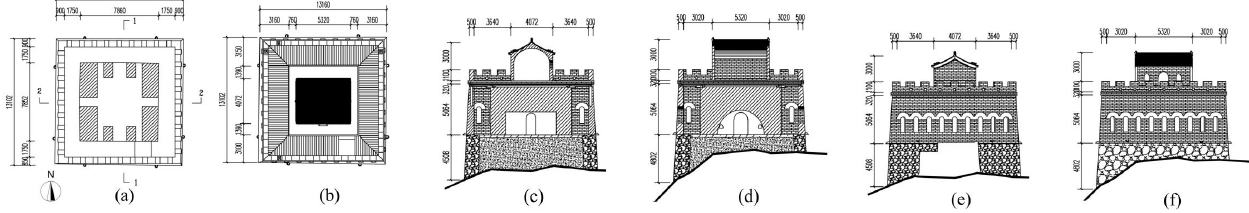
Figure 6. The virtual restoration scheme of Nine-eyes watchtower: ( a ) The plane drawing of the first floor; ( b ) The plane drawing of the second floor; ( c ) The cross-section drawing ,1-1; ( d )The cross-section drawing ,2-2; ( e )The west facade;( f ) The south